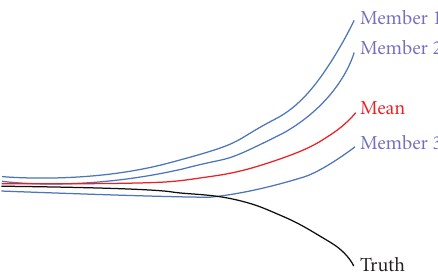
Figure 4: Monte Carlo forecast with finite